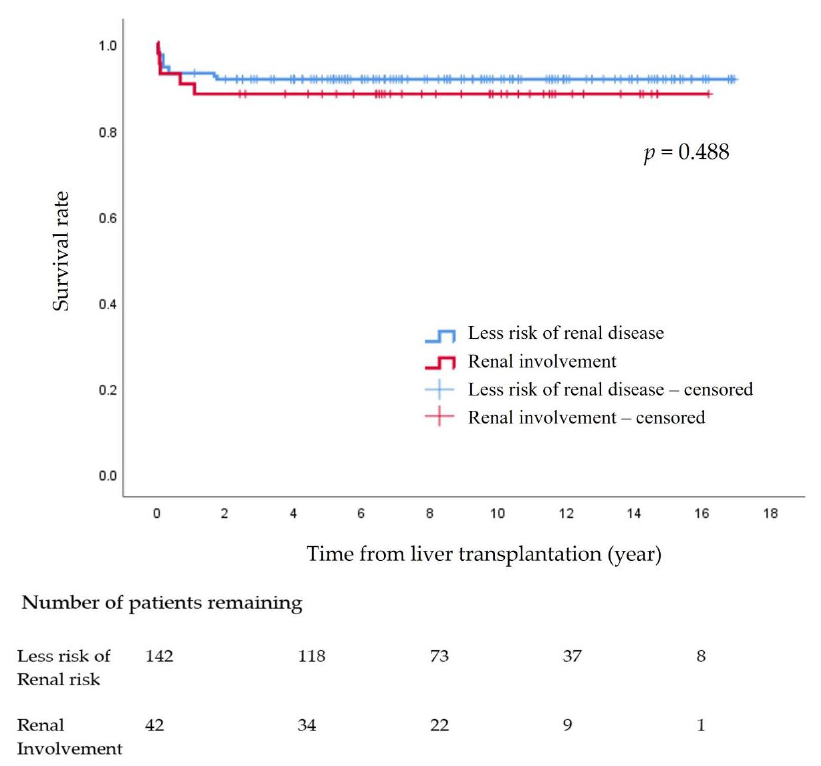
Figure 1. Survival rate after pediatric liver transplantation.